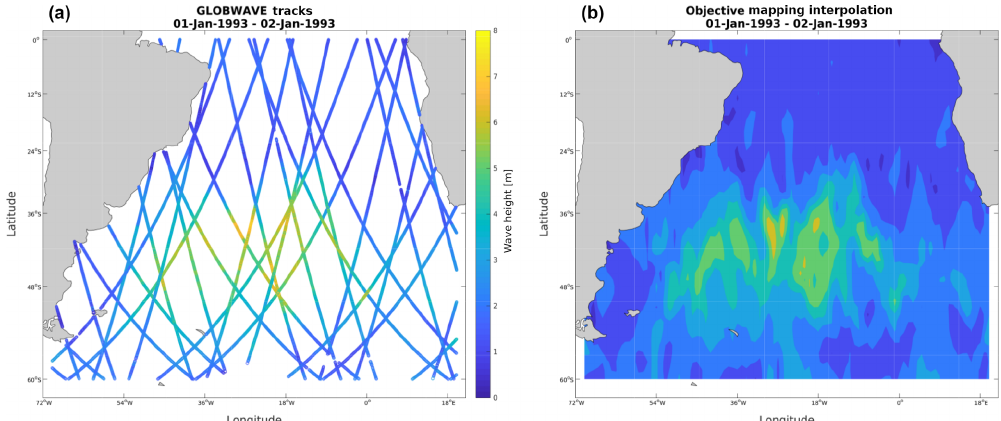
Figure 1. Example of multi-mission along-track data corresponding to a 2-day temporal window (a) and 2 ◦ × 2 ◦ gridded SWH field inter- polated through objective mapping (b)